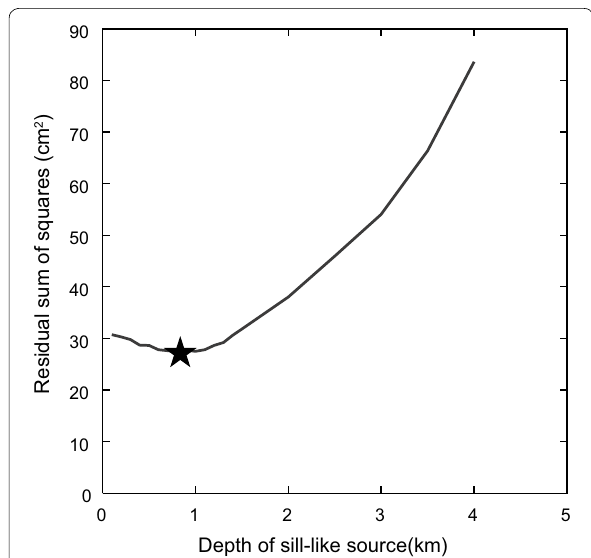
Fig. 8 The relationship between the optimum value of the depth and the residual sum of squares for crustal deformation after the beginning of the eruption on April 29, 2012. The star shows the optimum value of a depth of 800 m of the sill-like source. The curve shows the residual sum of squares at each